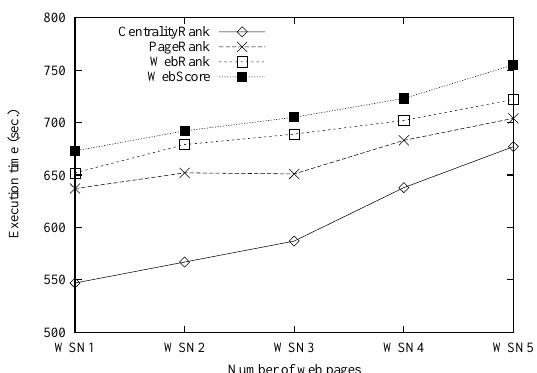
Fig. 6. Execution time comparison among algorithms